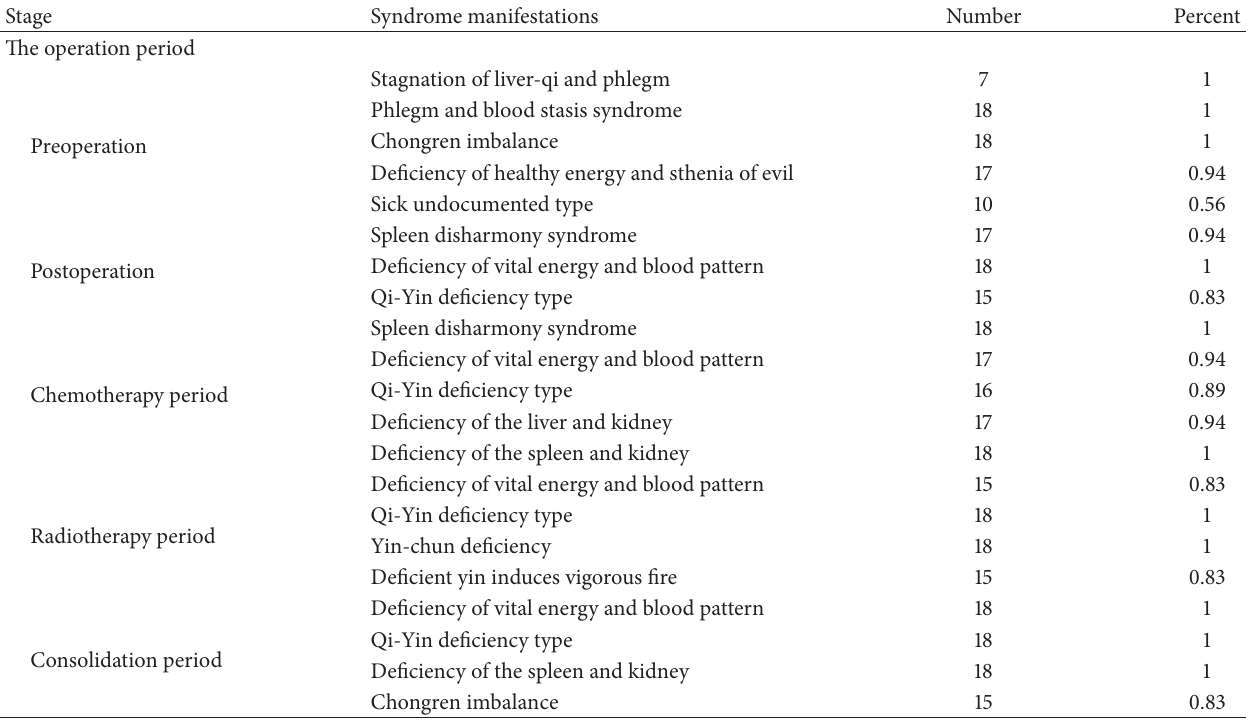
Table 3: The experts’ opinion on the classification of treatment phase and syndrome differentiation in the second round. Stage